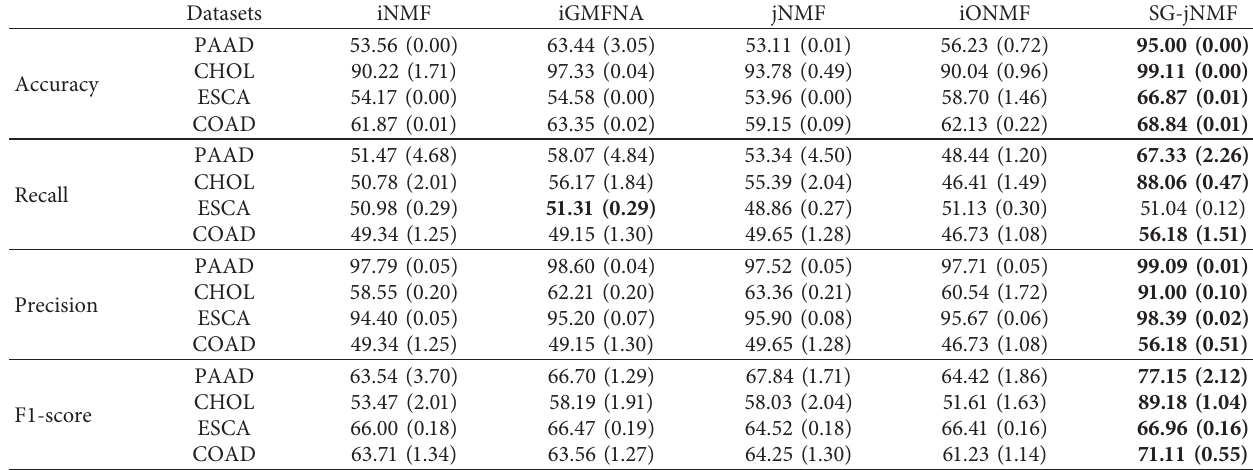
Table 3: Performance of different analysis methods.